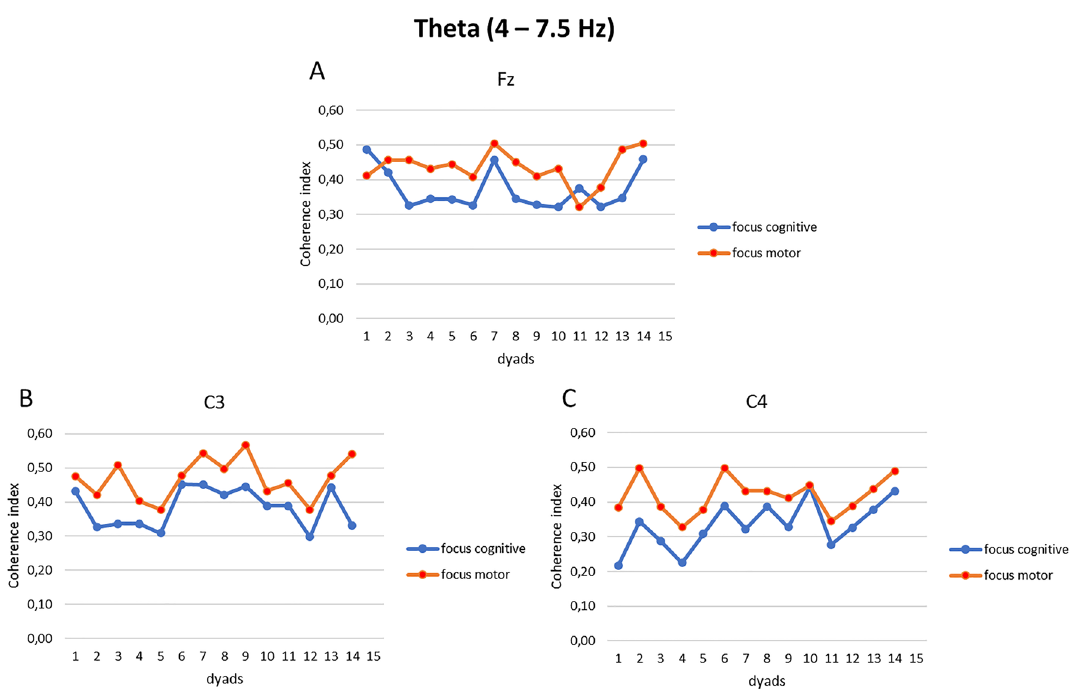
Figure 4. ( A – C ) EEG theta band coherence indices. Trend of the coherence indices modulation as a function of the synchronization tasks for the electrodes Fz ( A ), C3 ( B ), and C4 ( C ) in each